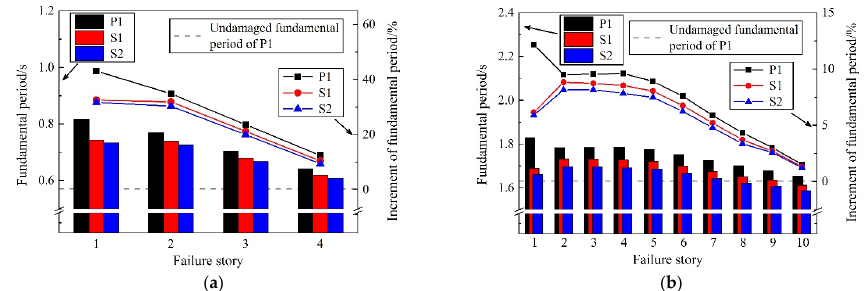
Figure 13. Fundamental period of residual structure. ( a ) 4-story. ( b ) 10-story.